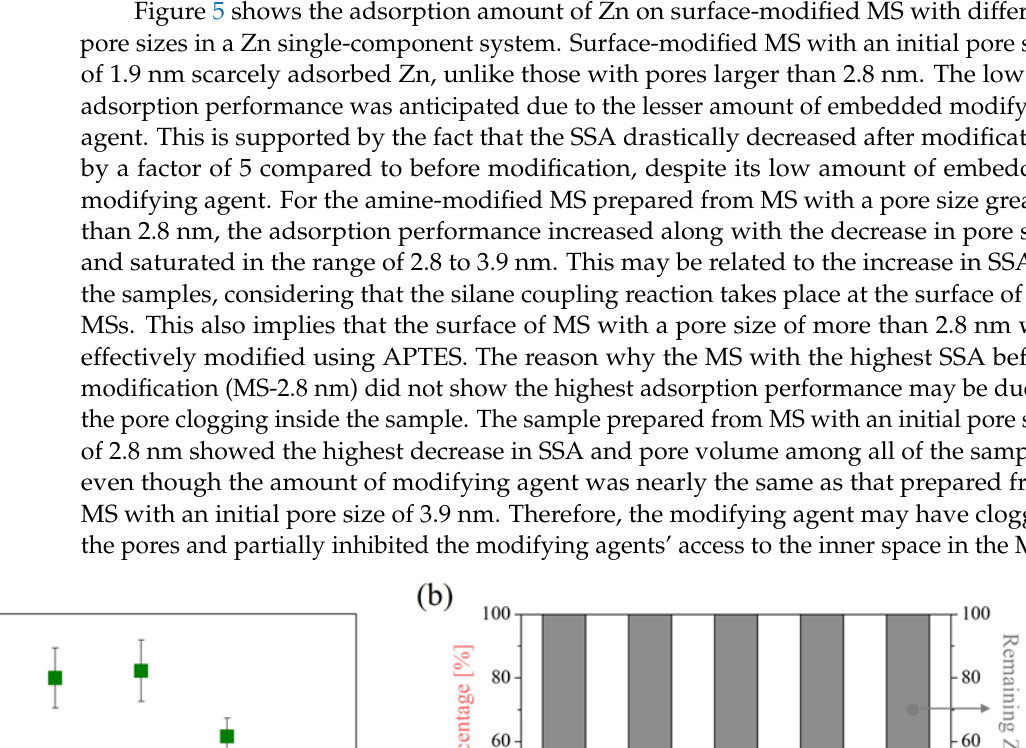
Table 1. List of p values obtained in statistical tests.